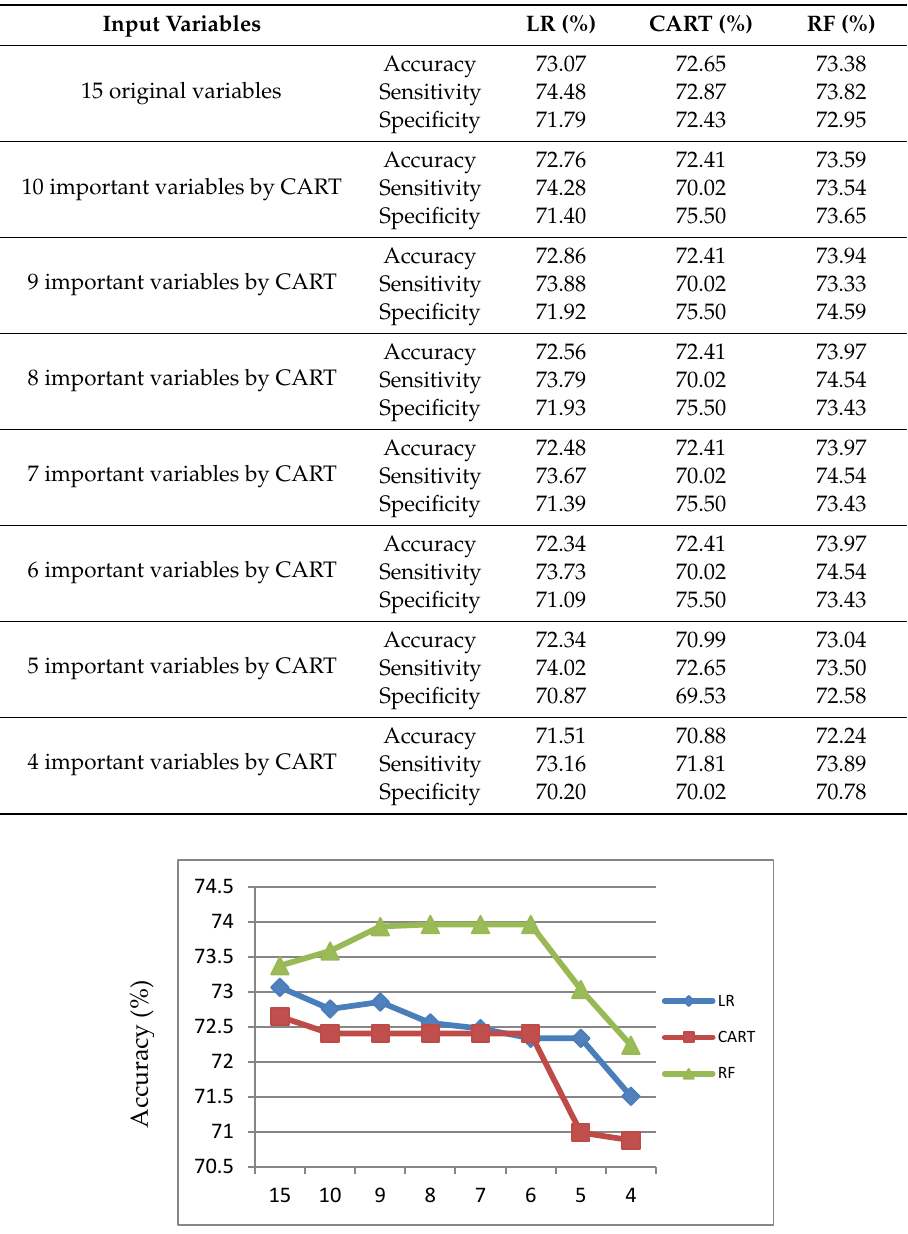
Table 6. Accuracy, sensitivity and specificity of LR, CART and RF with input of important variables identified by CART.